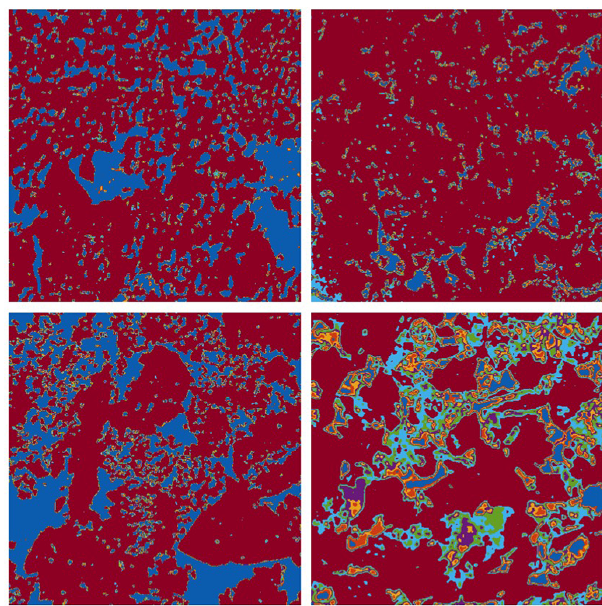
Figure 6. Slices of the segmented images used for the numeri- cal simulations to determine permeability and velocities. Top row: Carb-A with high (left) and low resolution (right). Bottom row: Carb-B with high (left) and low resolution